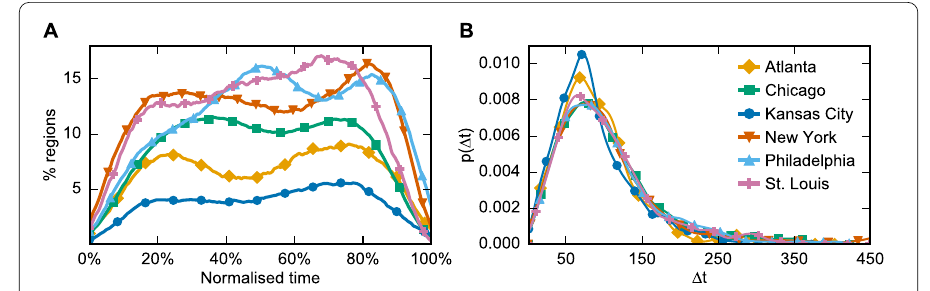
Figure 4 The circannual waves of crime travel across the city. To examine the local-level waves of crime from a global perspective, we count the proportional number of regions that exhibit a statistically significant band b at the time step t in each city (i.e., the composed scale-averaged power C b c ( t )). In the case of the circannual band, C b c ( t ) presents a typical value without much variability throughout the time series, suggesting a possible equilibrium at city level (shown in ( A ) for selected cities). However, the number of weeks (cid:5) t that each region keeps this period continuously follows a probability distribution ( B ) that decays far before the complete criminal series, implying that these waves move across the city. Such continuous movement supports the view of cities in disequilibrium. In the plots, the legend in ( B ) also applies to the curves in ( A ). Normalised time refers to the proportional amount of time to the whole time series